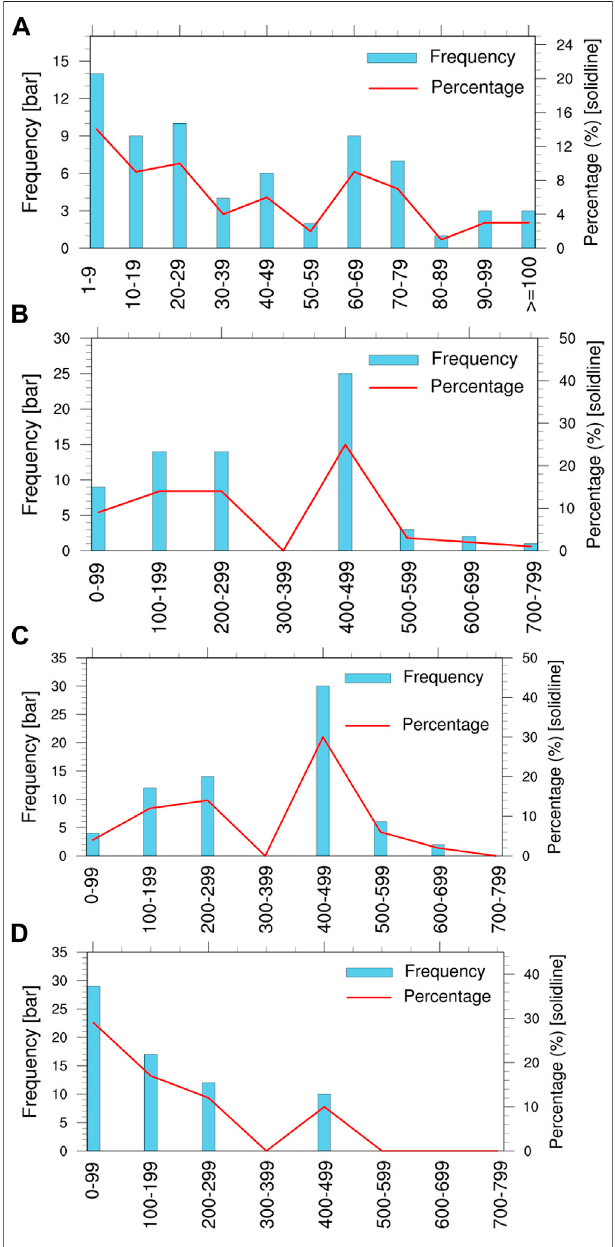
FIGURE 7 | Frequency and probability of (A) the number of sand-dust processes, (B) maximum number of suspended-dust stations, (C) maximum number of blowing-sand stations, and (D) maximum number of sand-dust storm stations.